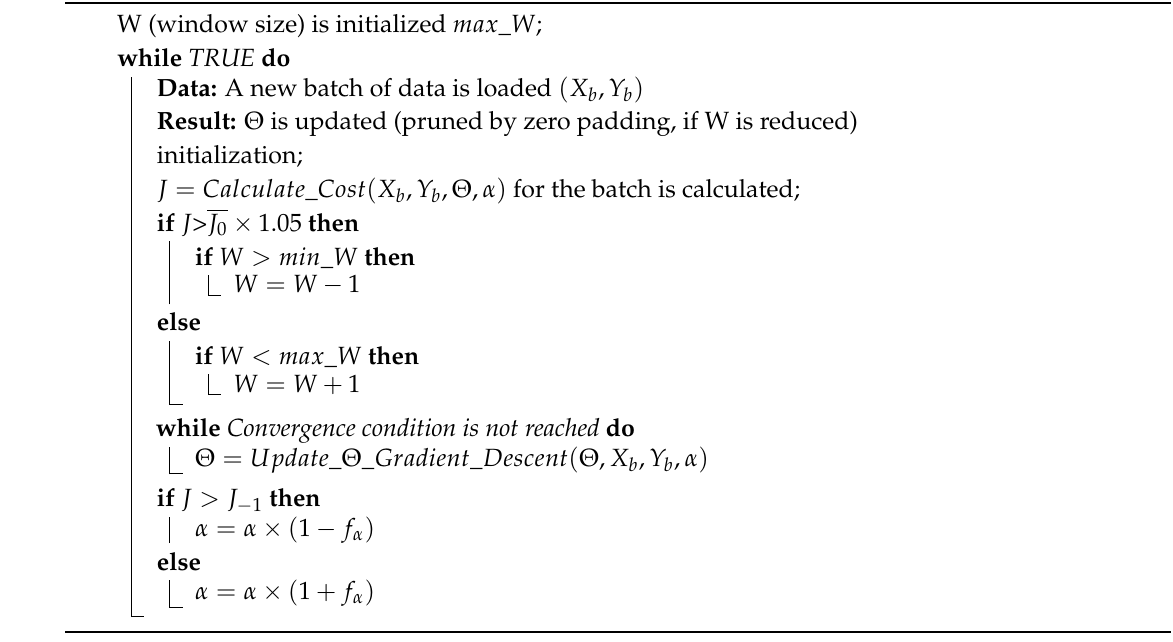
Algorithm 1: Adaptive incremental linear regression gradient descent